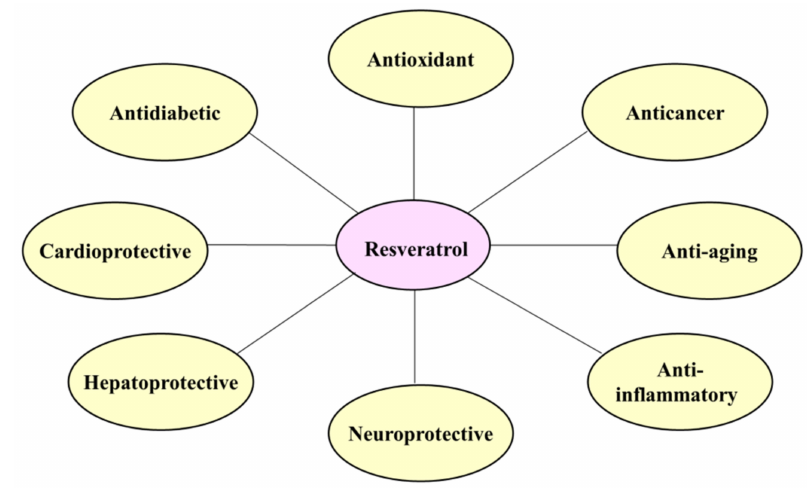
Figure 2. Physiological functions of